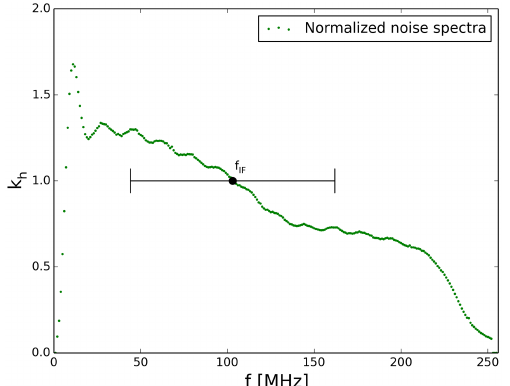
Figure 6. Estimated system frequency response k h based on the digitized noise spectra. The black dot indicates the beat signal fre- quency ( f IF = 102MHz ) when the relative speed between the lidar and the measured range gate is zero. The horizontal line indicates the range of variation of the beat signal frequency produced by the projection of the aircraft speed on the lidar LOS, when the system operates in scanning mode.